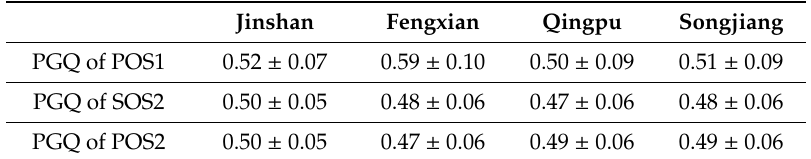
Table 1. Mean and standard deviations of the proportion of good quality (PGQ) for POS1, SOS2, and POS2 in the four counties, respectively.